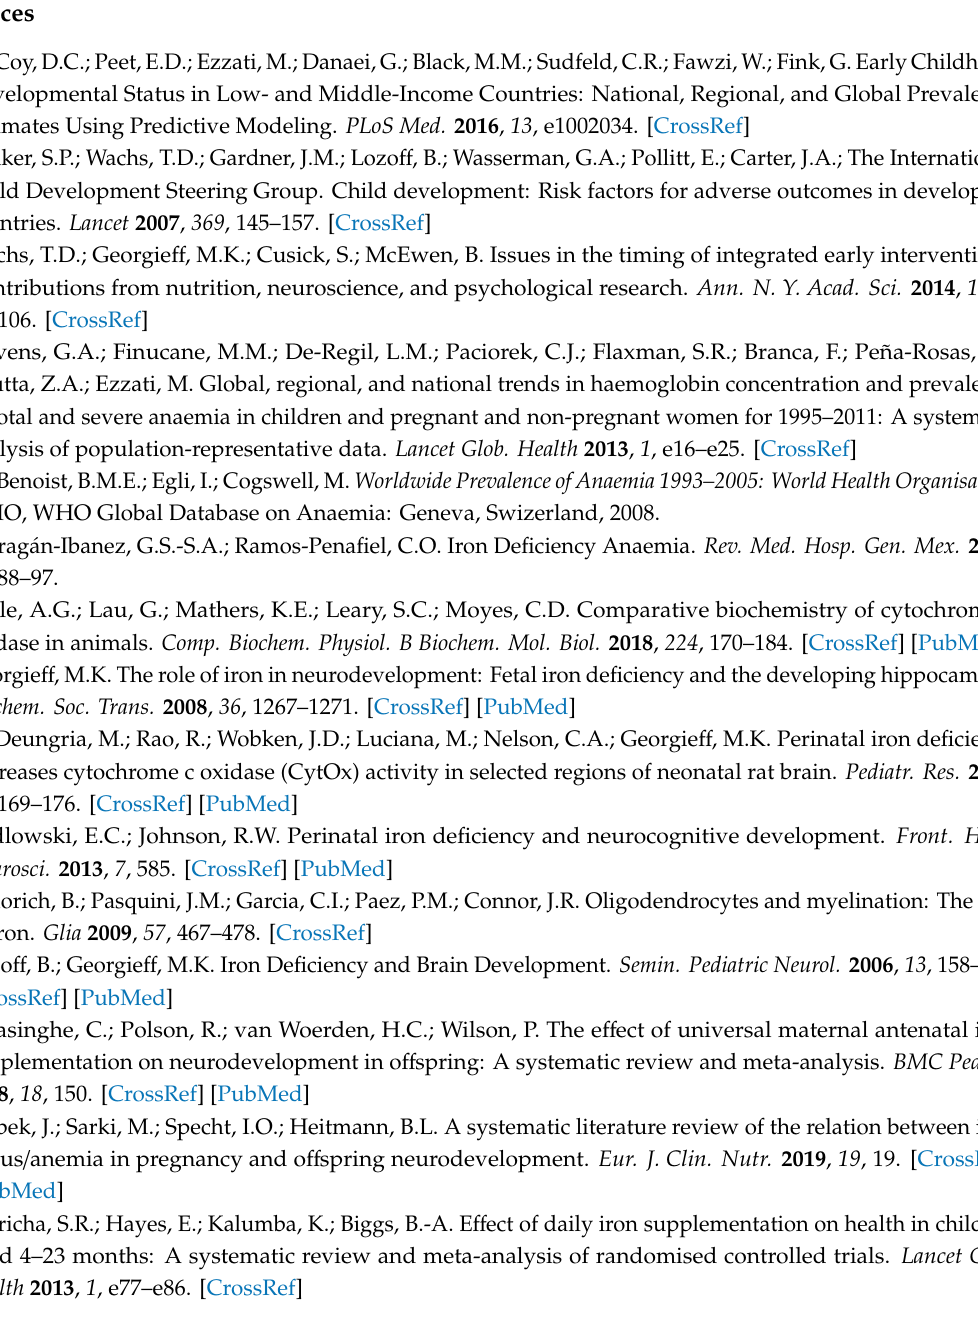
Table S1. PRISMA Checklist; Table S2. Search Strategy; Table S3. Cross-Sectional Studies; Table S4. Longitudinal Studies; Table S5. Intervention Studies; Table S6. Risk of